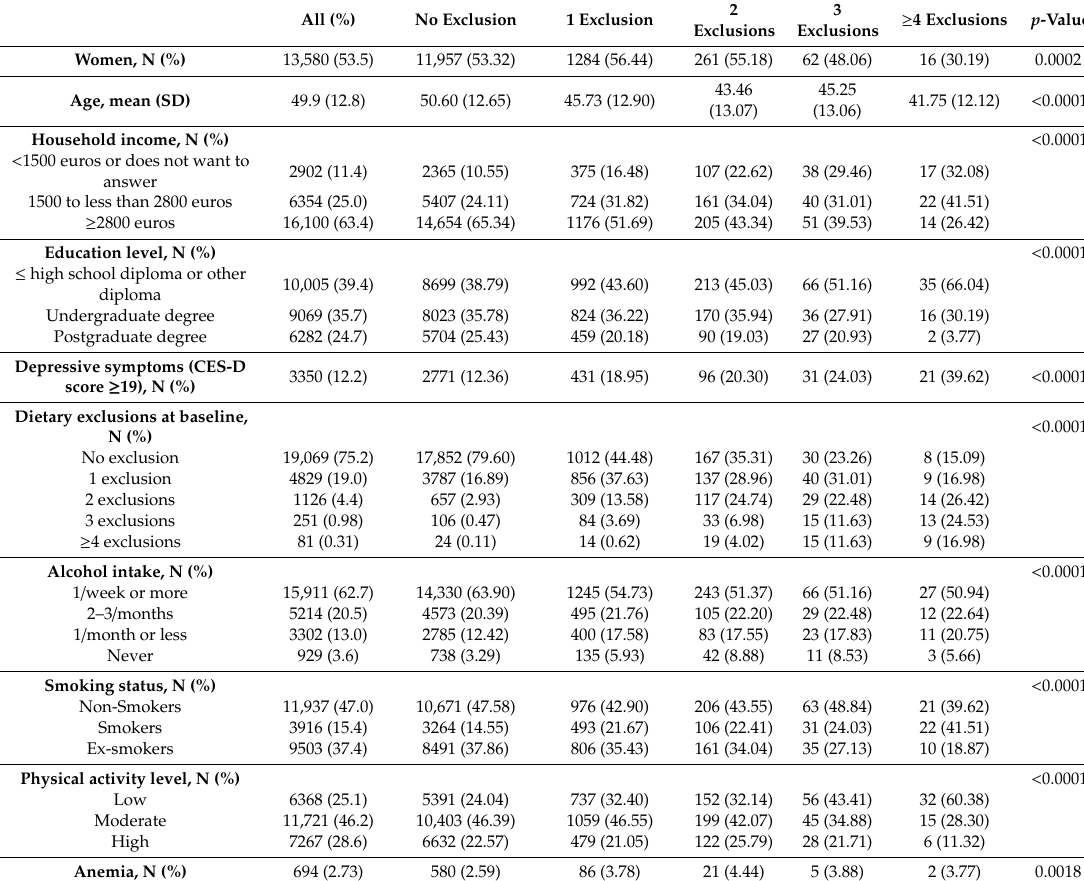
Table 2. Participant’s baseline characteristics by dietary exclusions at follow-up (N = 25,356).